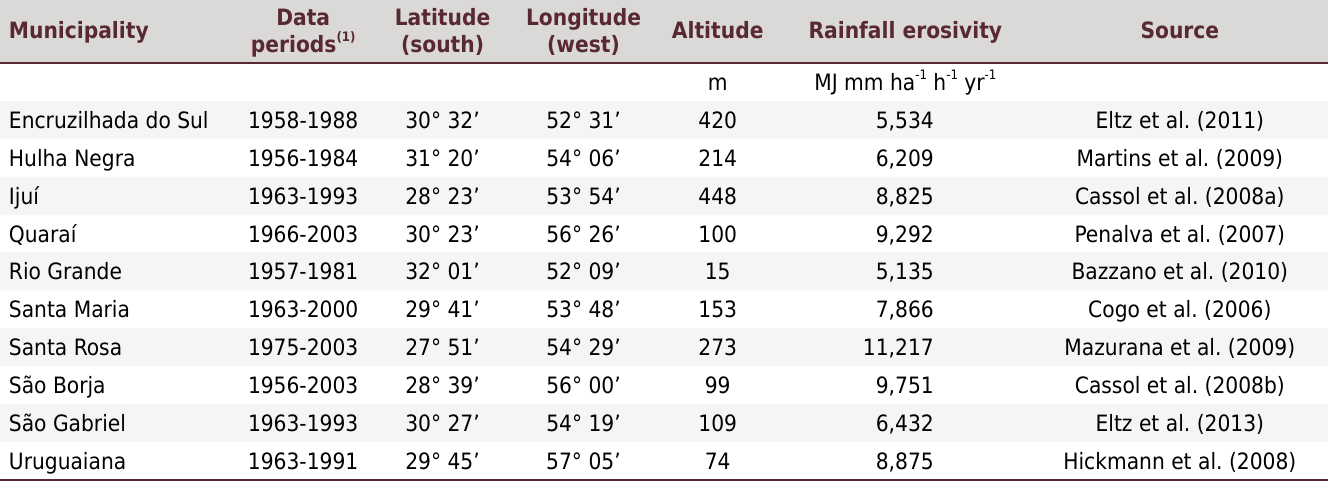
Table 1. Rainfall erosivity estimated for different localities of the state of Rio Grande do Sul